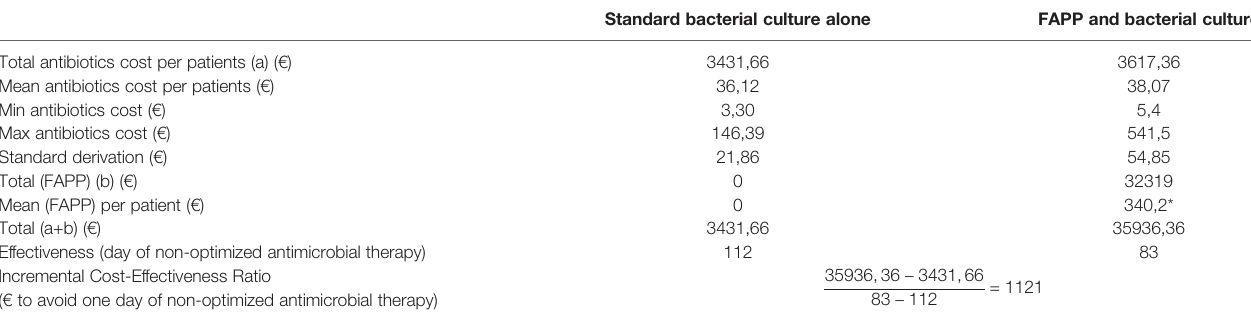
TABLE 4 | Medico-economic